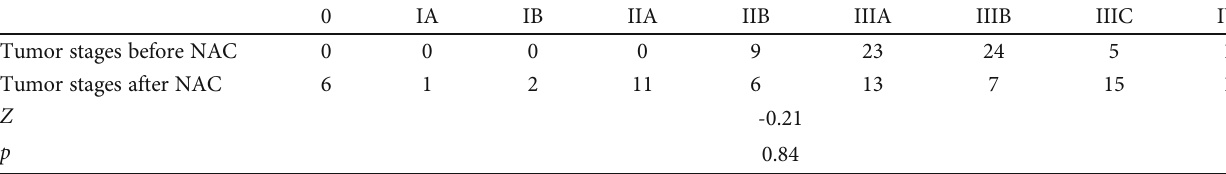
Table 2: Di ff erences in TNM stages between before NAC and after surgery.